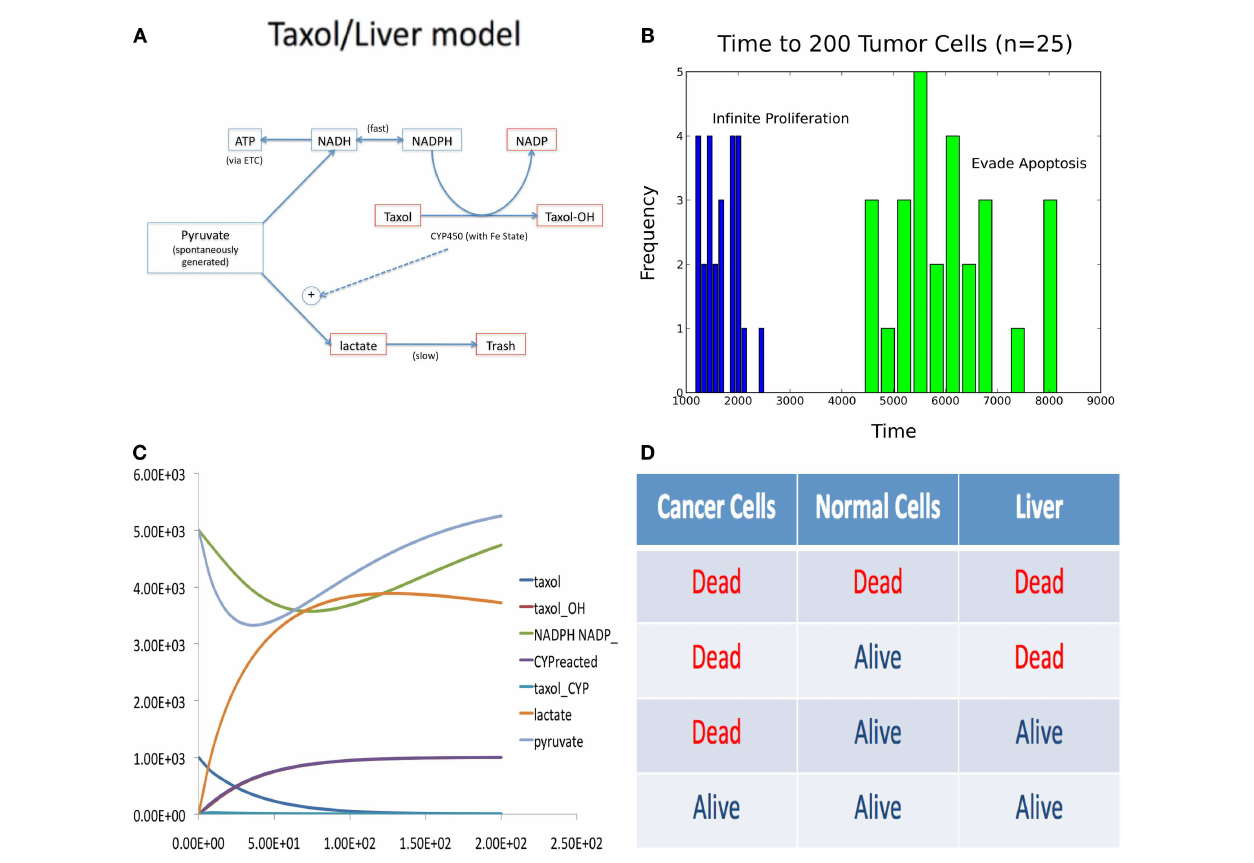
FIGURE 4 | Figures accompanying the composition model . (A) Wiring diagram of liver model. (B) Time to tumor for different phenotypic aberrations. (C) Sample trace of ODE liver model simulation. (D) Four possible steady-state outcomes of composite model simulation, with differentTaxol delivery